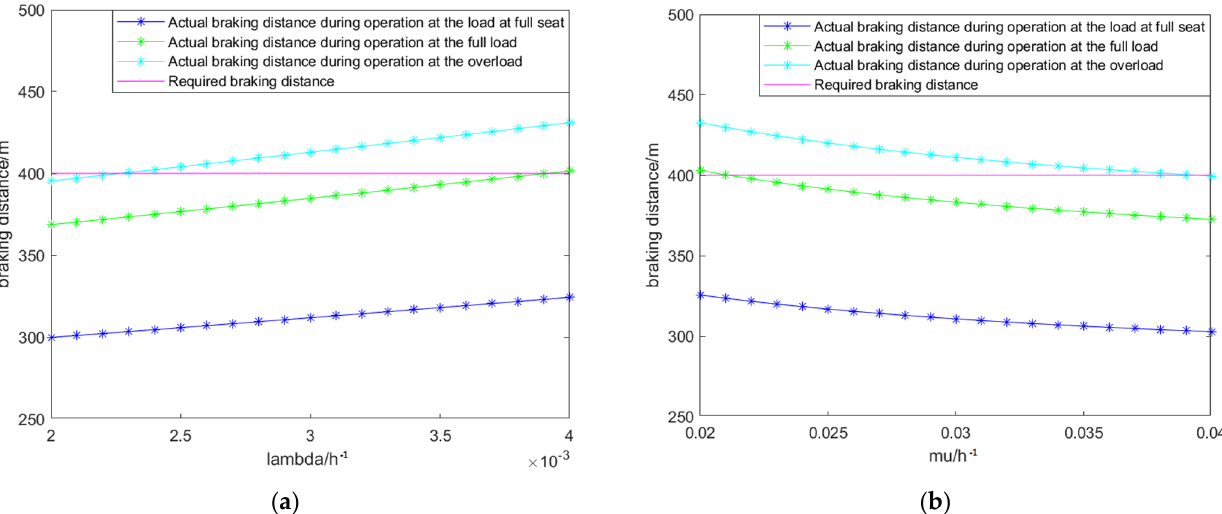
Figure 6. Average braking distance in one overhaul interval verified with the different parameters of motors: ( a ) braking distance verified with λ ; ( b ) braking distance verified with λ .